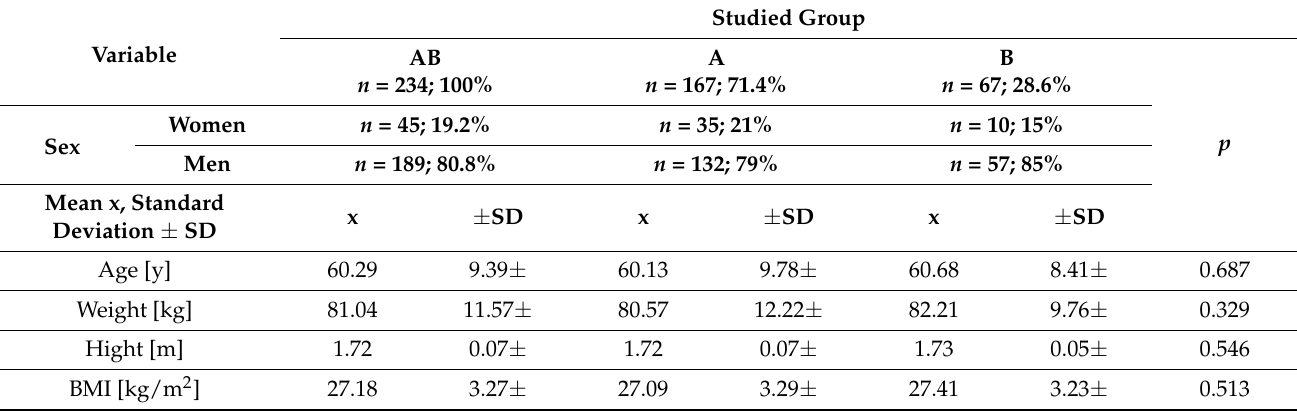
Table 1. Characteristic of the studied